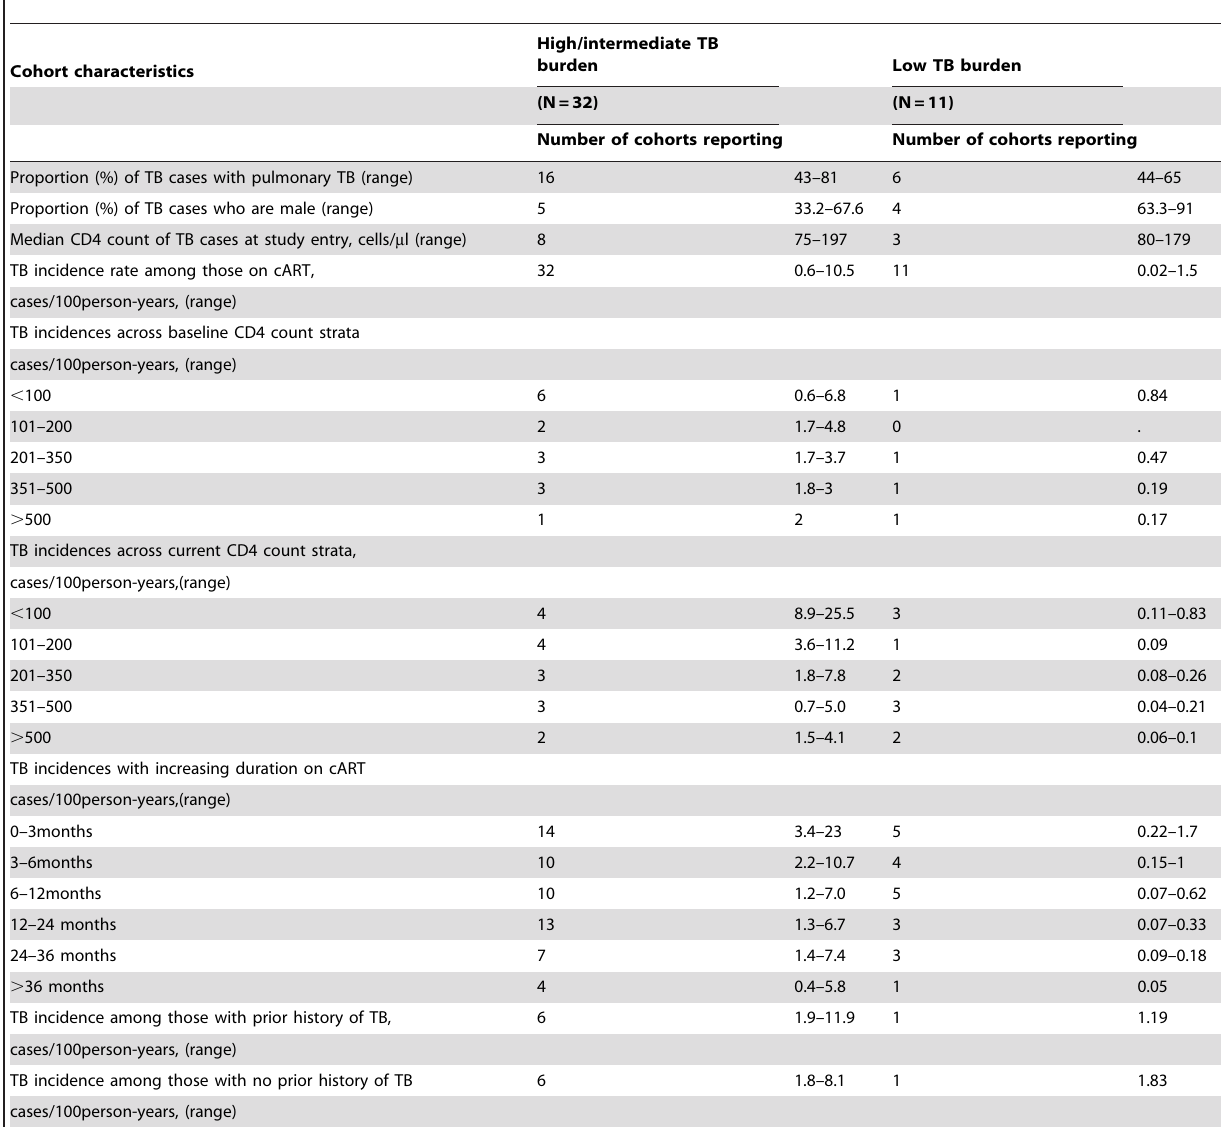
Table 3. TB cases characteristics and incidence rates reported in high burden cohorts and in low burden